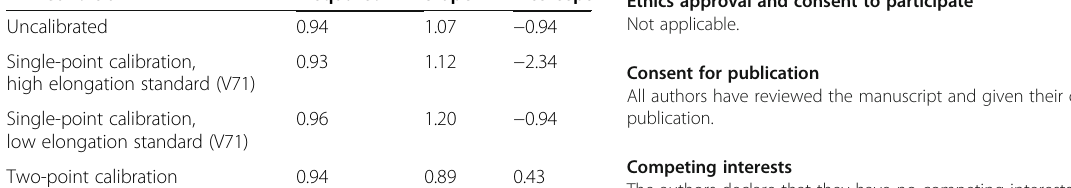
Table 8 Correlation and linear regression between Stelometer and HVI elongations on a single instrument HVI Condition R-squared